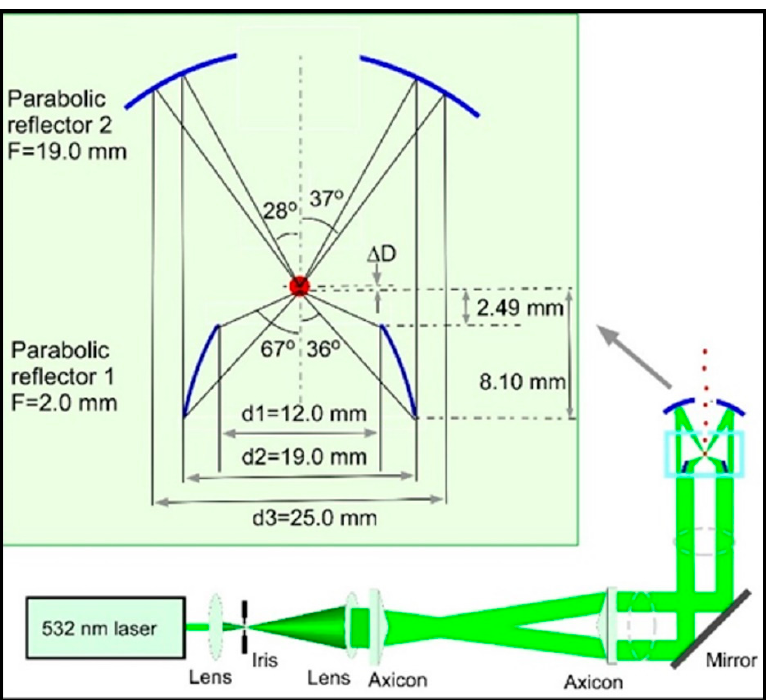
Figure 2. Schematic of the optical trapping apparatus with the detailed alignments and dimensions of the two focusing parabolic reflectors. (Reprinted with permission from [50] under Open Access License. Copyright (2019) The Optical Society of America).